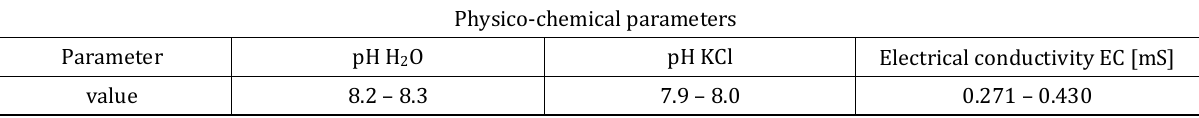
Table 1. Physico-chemical characteristic of ground (wastes) (after Kucharski et al., 2010, changed)